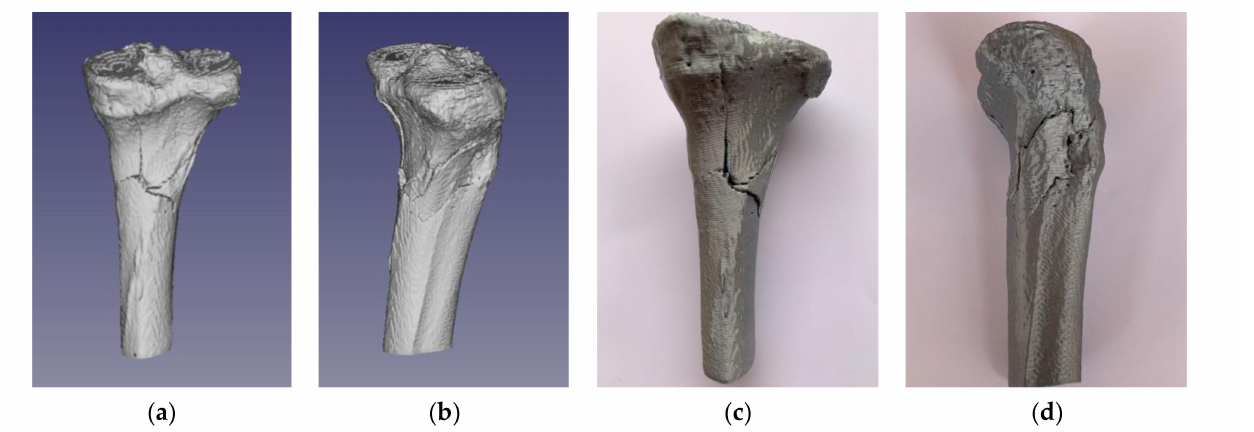
Figure 11. Tibial plateau fracture reconstruction result supported by the alignment algorithm: ( a ) posterior view of the standard triangle language (STL) model; ( b ) lateral view of the STL model; ( c ) posterior view of the 3D printed replica; ( d ) posterior view of the 3D printed